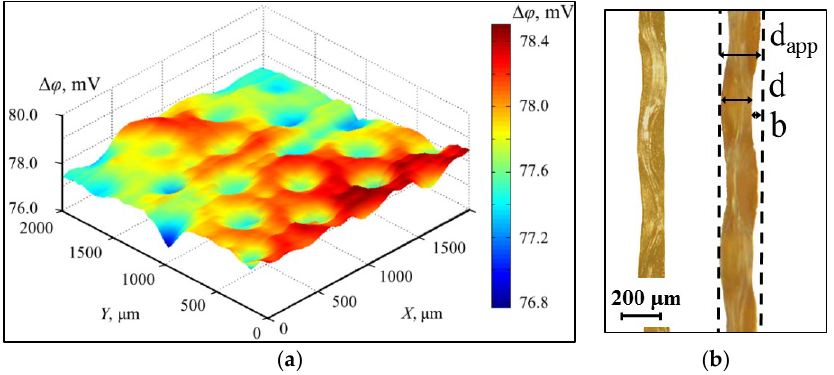
Figure 16. Topography of potential distribution near the surface of the CMX membrane ( a ) and optical images of cross sections of the dry and swollen CMX membrane ( b ); the threads of reinforcing cloth are seen as light lines. Measure d is the true membrane thickness, d app is the apparent thickness determined using a micrometer, and b is the distance between the top of a hill and the bottom of a valley on the surface. Adapted from [120].